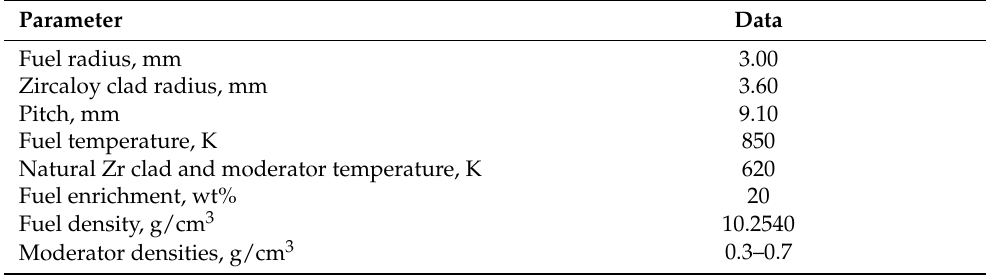
Table 1. RBWR-analogue pin-cell parameters.